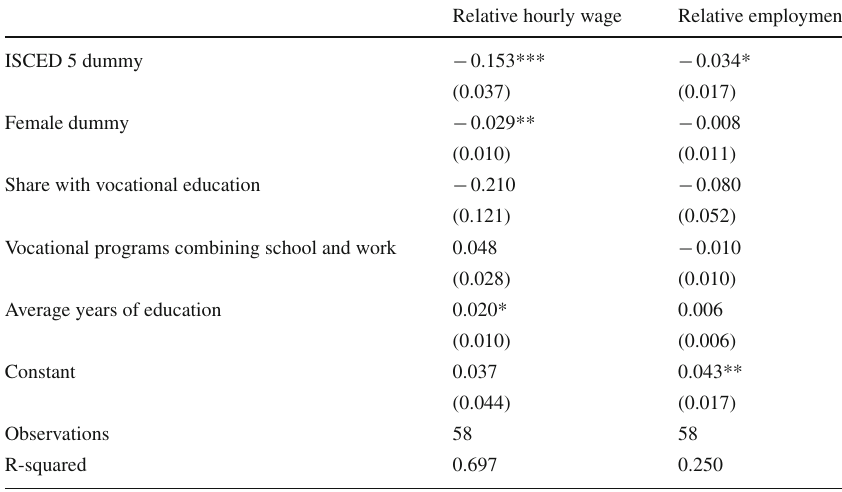
Table 7 Partial correlations between estimated differences in log hourly earnings and country specific effects. Both genders and ISCED levels. Dependent variable: estimated differences in log hourly earnings and in employment. Source : Calculations based on PIAAC